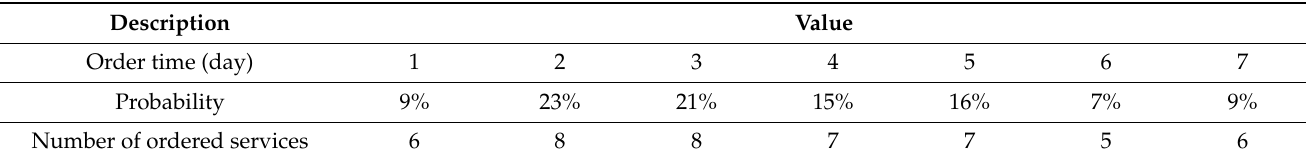
Table 2. The probabilistic parameters for services order times.